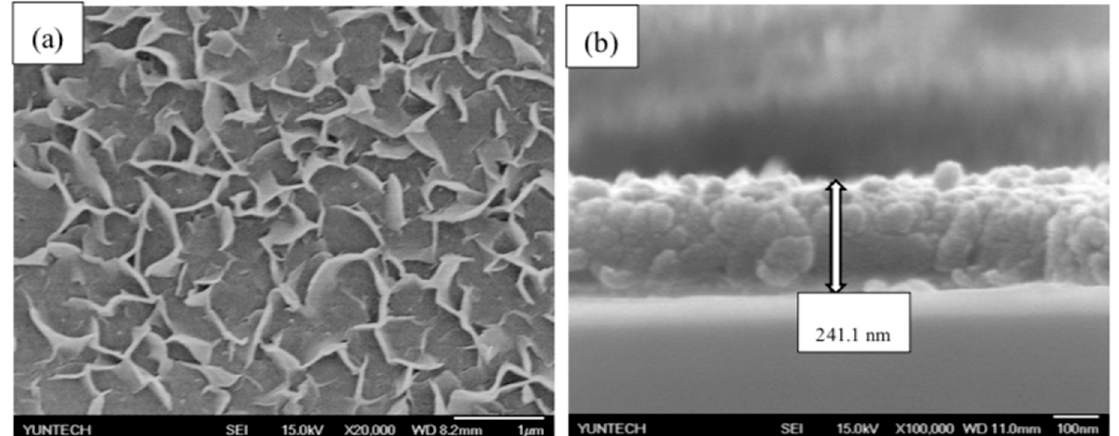
Figure 5. FE-SEM images of AZO nanosheets. ( a ) top view and ( b ) cross section.